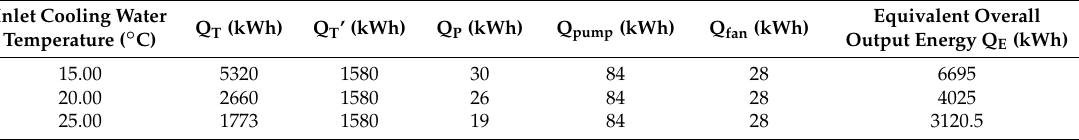
Table 6. Time − wise results of inlet cooling water temperature study.